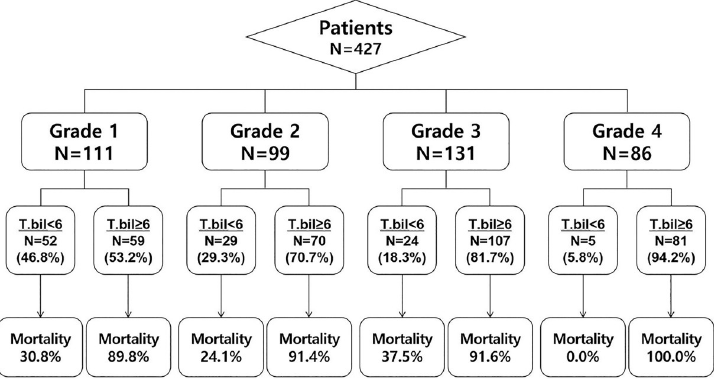
Fig 3. Bilirubin recovery ( < 6 mg/dL) or non-recovery from extreme hyperbilirubinemia and subsequent mortality according to the peak bilirubin grade. Abbreviation: Bilirubin recovery, bilirubin decrease below 6 mg/dL.